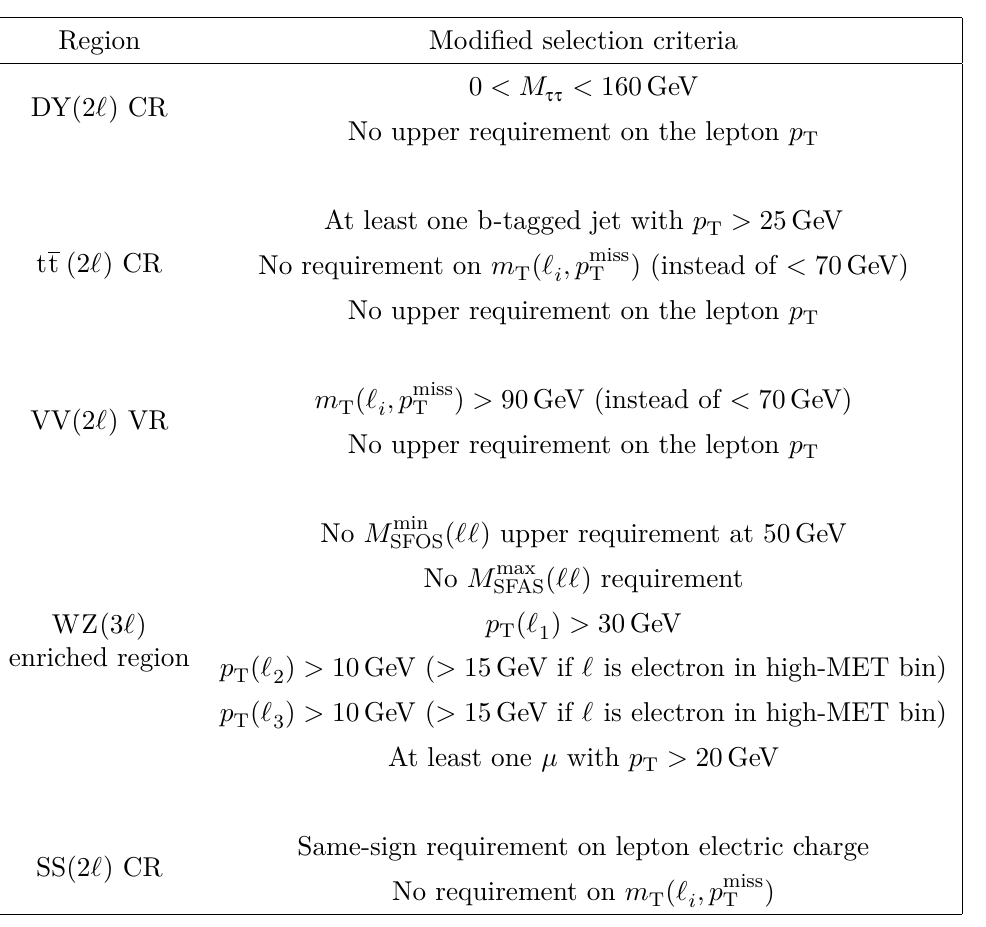
Table 3 . Summary of changes in the selection criteria with respect to the SR for all the background control and validation